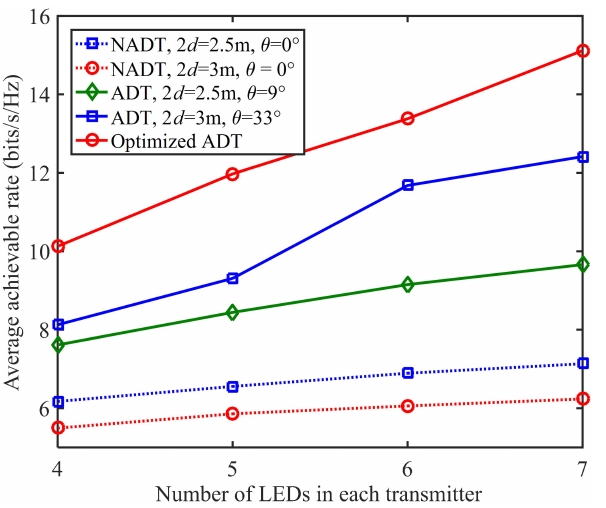
Figure 6. Average achievable rate vs. the number of LEDs in each